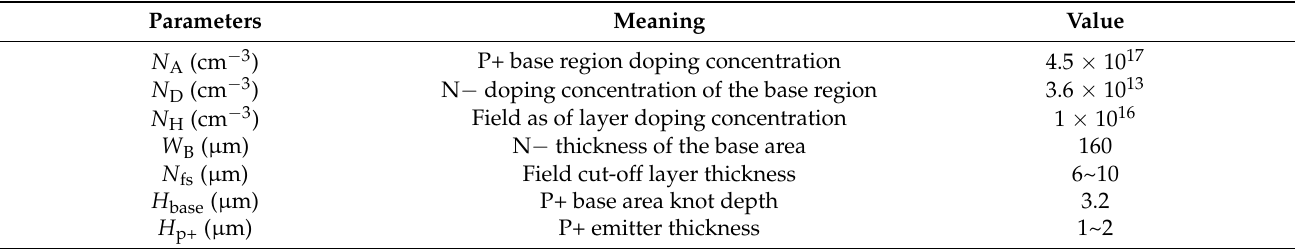
Table 3. Key parameters.